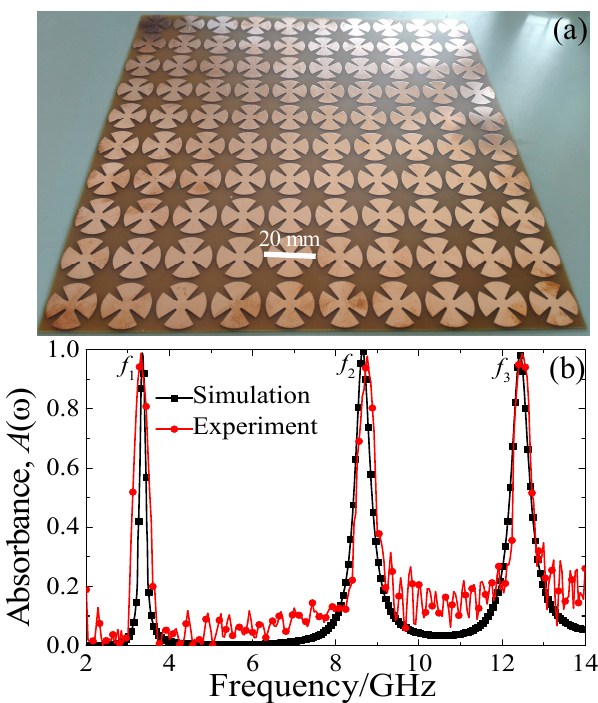
Figure 2. ( a ) Photograph of the fabricated MMA sample; ( b ) the simulated and measured absorbance of the triple-band MMA for normal incidence.